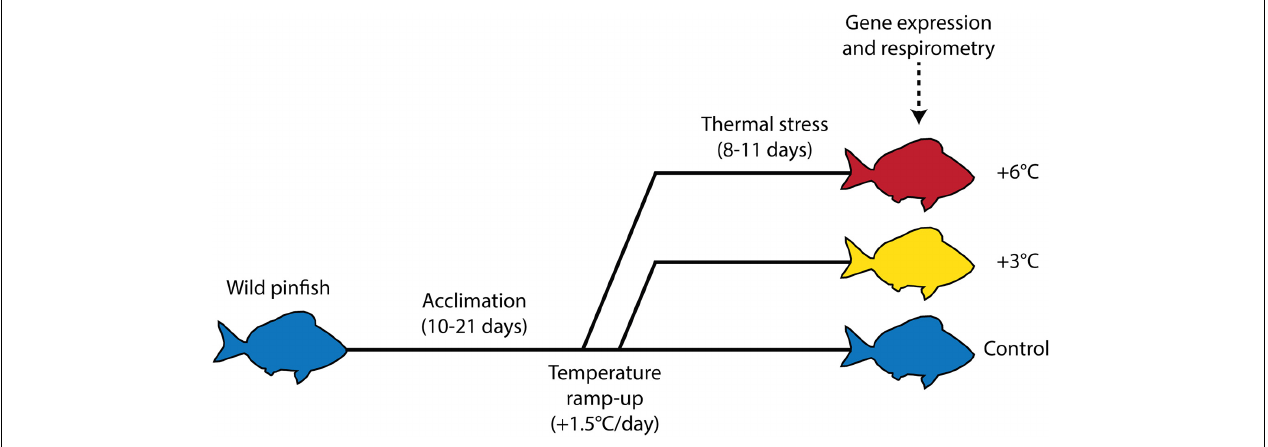
FIGURE 1 | Simplified schematic of the experimental design. Wild pinfish were acclimated to the aquaria for 10–21 days. Temperatures for the experimental groups were then raised from the control (21 ◦ C) at a rate of 1.5 ◦ C per day until the appropriate experimental temperature was reached (24 or 27 ◦ C). After 8–11 days of exposure, tissues were taken for analyses of gene expression, and routine metabolic rate was